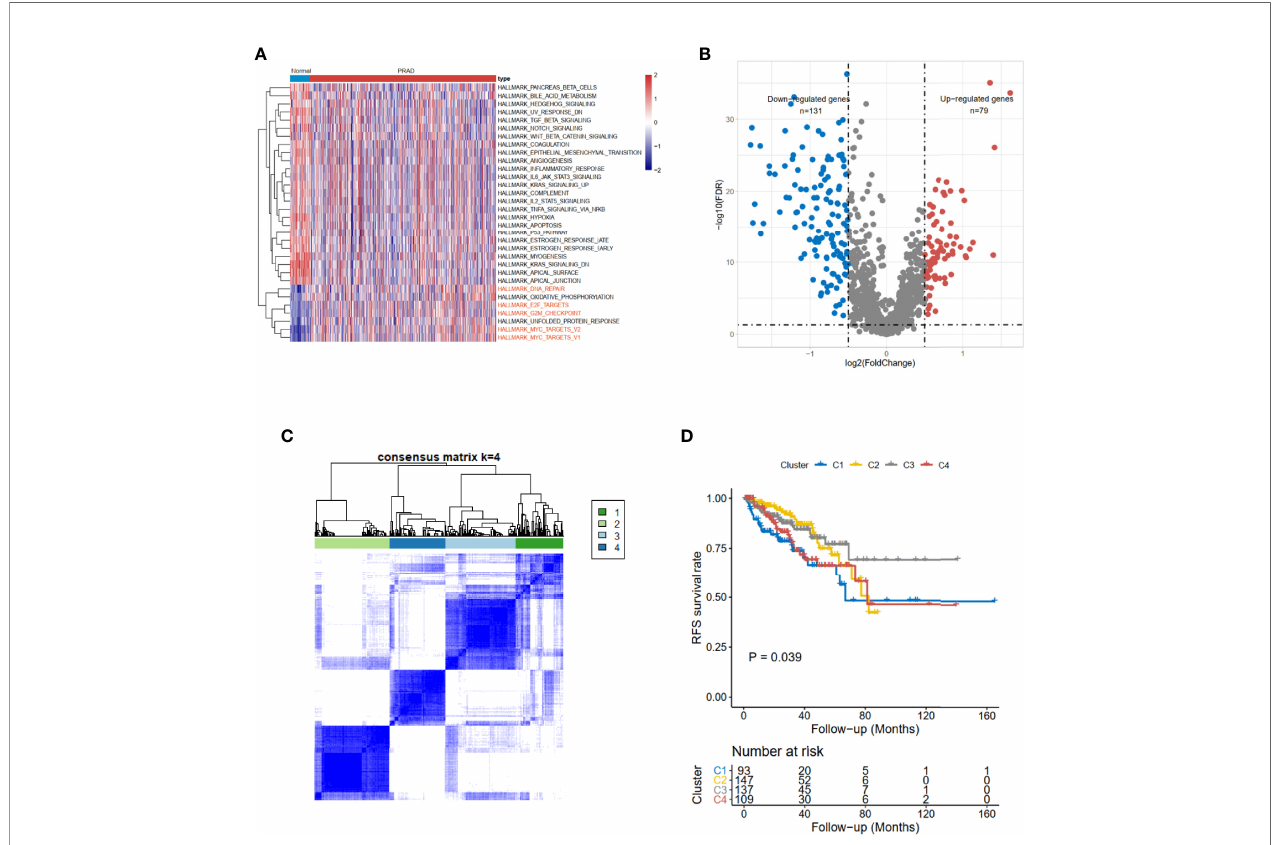
FIGURE 1 | Identi fi cation of cell cycle-related DEGs and consensus clustering in TCGA-PRAD cohort. (A) The hallmark enrichment of prostate cancer compared with normal tissues. (B) The volcano plot of cell cycle-related DEGs between high- and low-risk groups (FDR < 0.05 and logFC > 0.5). (C) Consensus matrices for a solution with 4 clusters based on DEGs. (D) Kaplan – Meier curves show the prognostic value of the four patterns. DEGs, differentially expressed genes; TCGA-PRAD, The Cancer Genome Atlas — Prostate Cancer; FDR, false discovery